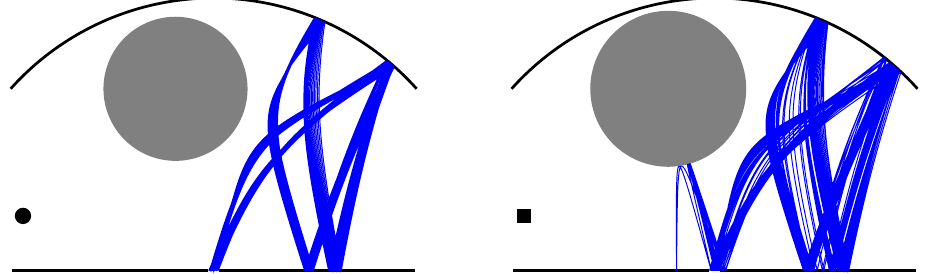
Figure 13: Reflected trajectories for the two marked points of enhanced conductance in Fig. 12. Gray areas: Classically forbidden depletion disks of the tip